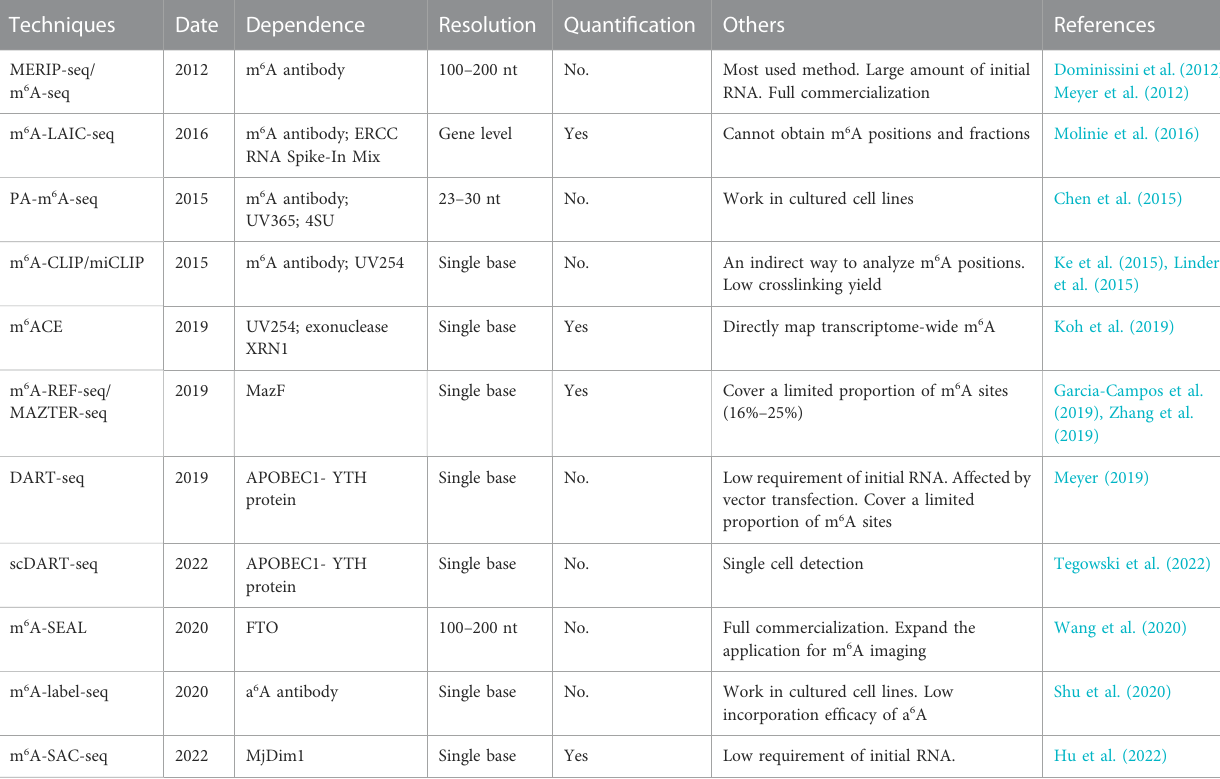
TABLE 2 Detection methods of m 6